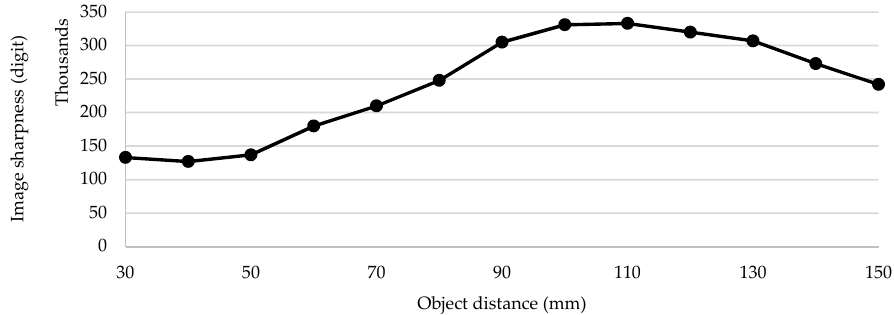
Figure 11. Measured voltage/distance characteristics of the distance measurement subsystem.